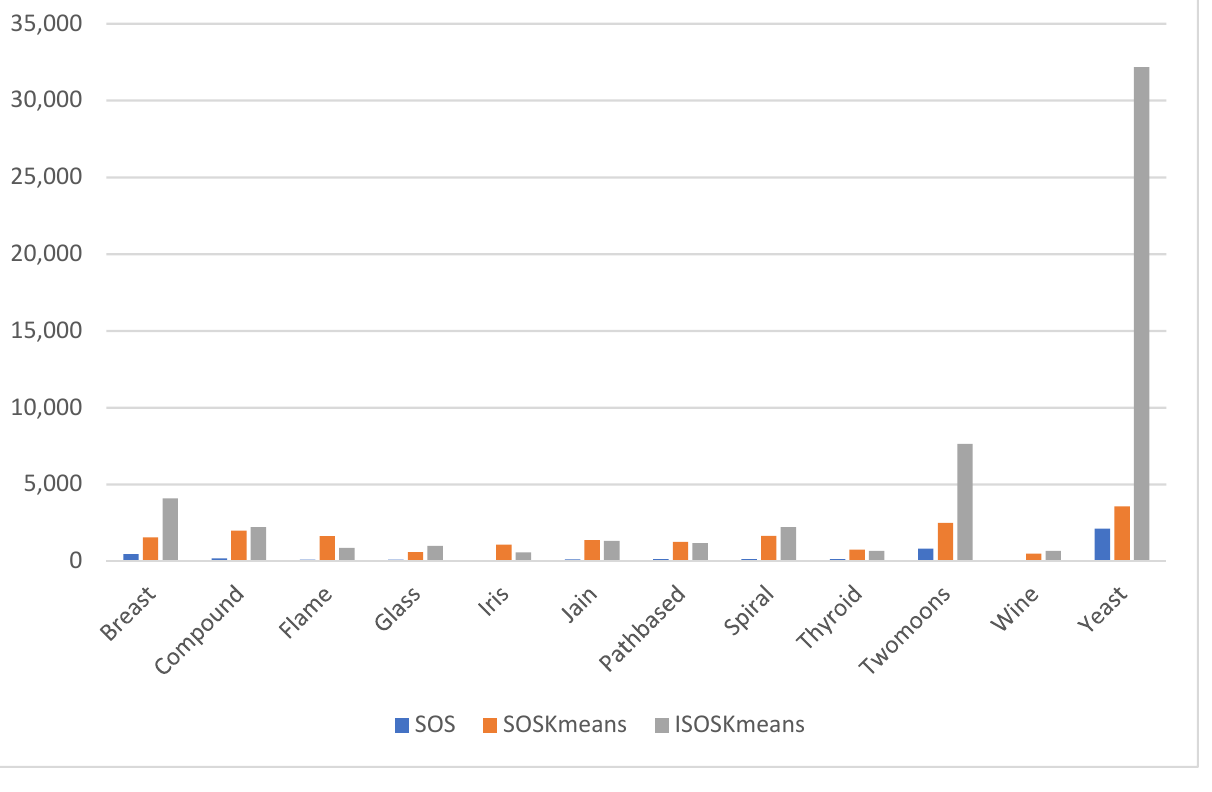
Figure 7. Analysis of computational times of SOS, SOSK-means and ISOSK-means under the CS index.